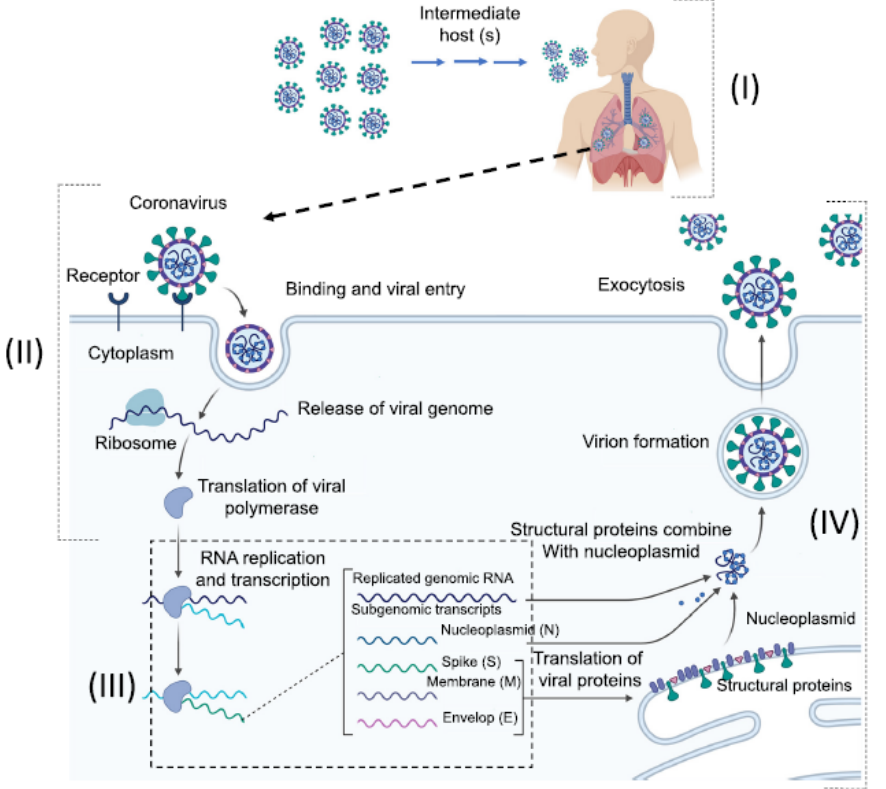
Figure 4. Illustration of the mechanism by which coronavirus infection occurs and its mode of replication. Reprinted from Acter et al. [73]. Copyright 2020 with permission from Elsevier.